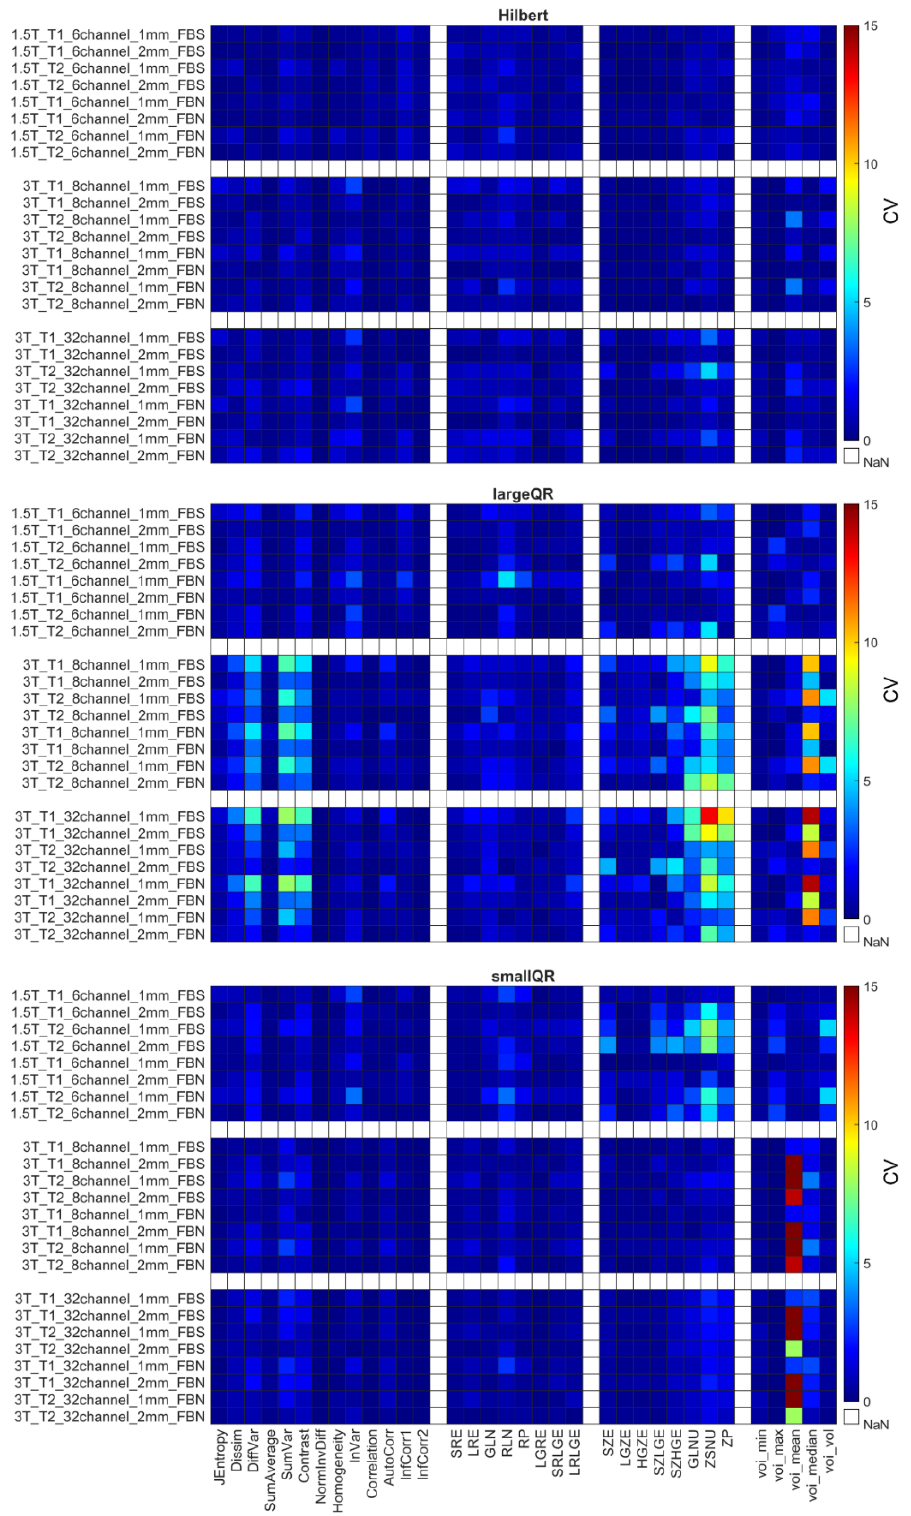
Figure 5. CV of radiomics parameters for Hilbert, large QR, and small QR code cubes. Four radiomics parameter groups (GLCM, GLRLM, GLRLM, and histogram-based) are shown on the horizontal axis. The CV is expressed in %.